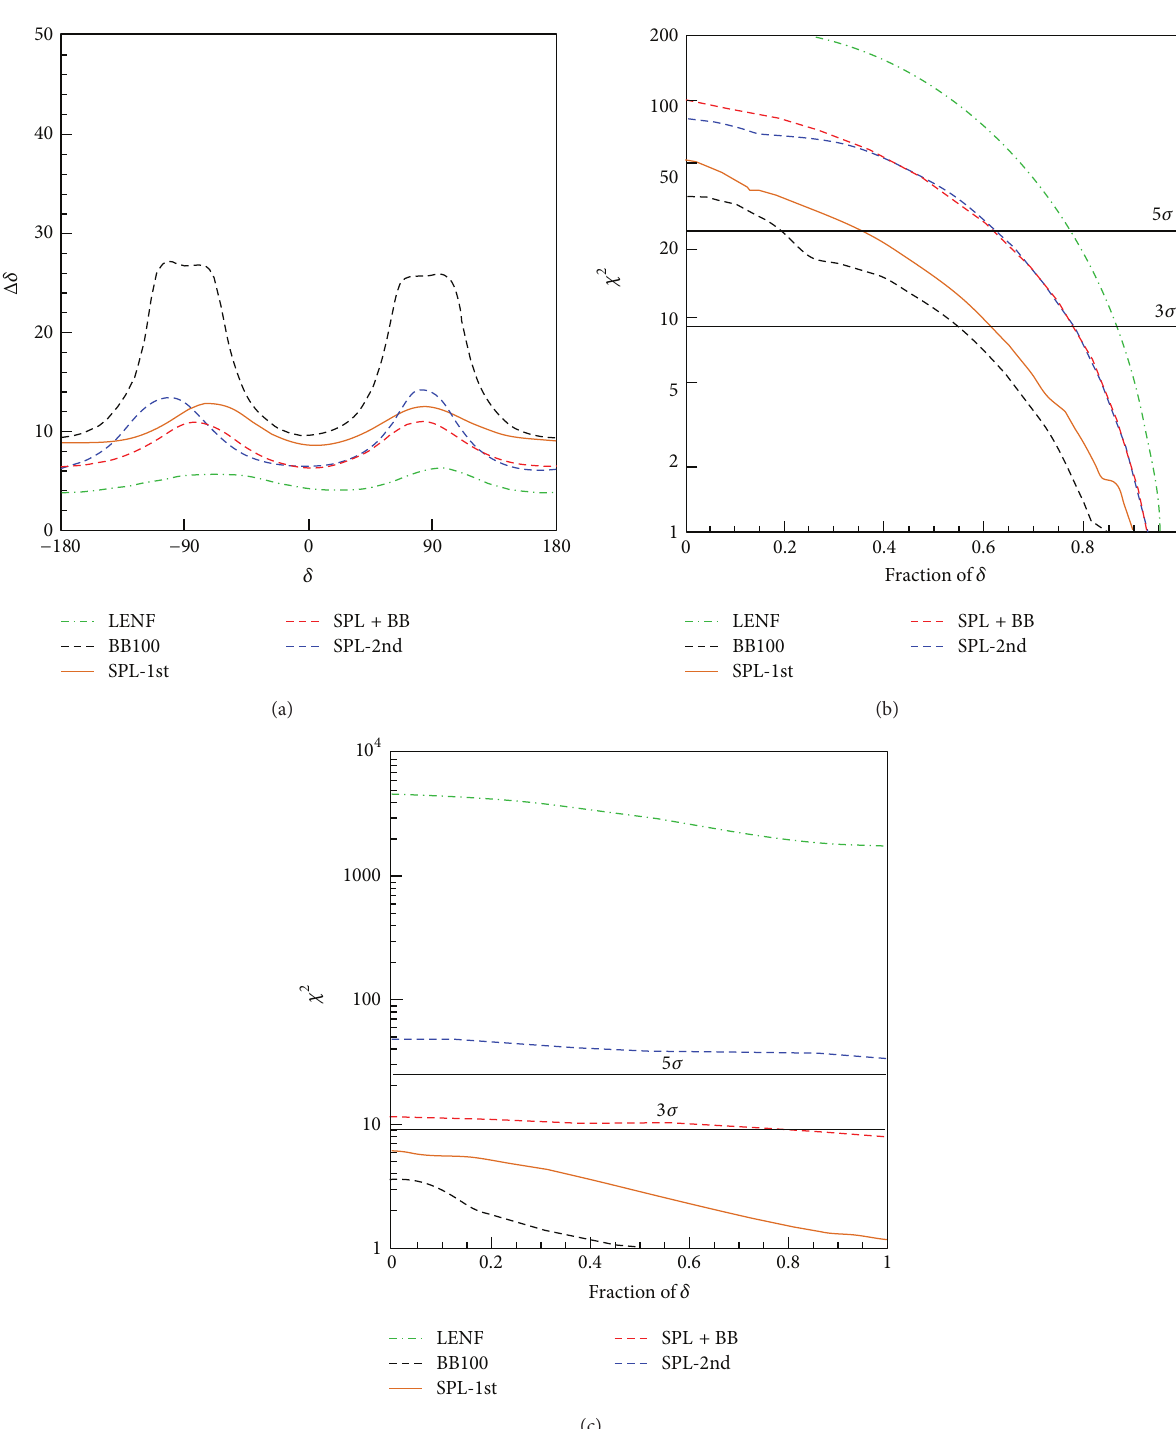
Figure 22: Summary of the physics performance of the facilities described in the text. (a) The 1 𝜎 measurement errors for the CP angle 𝛿 as a function of 𝛿 . (b) The range of 𝛿 for which a 3 and 5 𝜎 measurements of 𝛿 can be made. (c) The range of 𝛿 for which 3 and 5 𝜎 measurements of the neutrino mass hierarchy can be